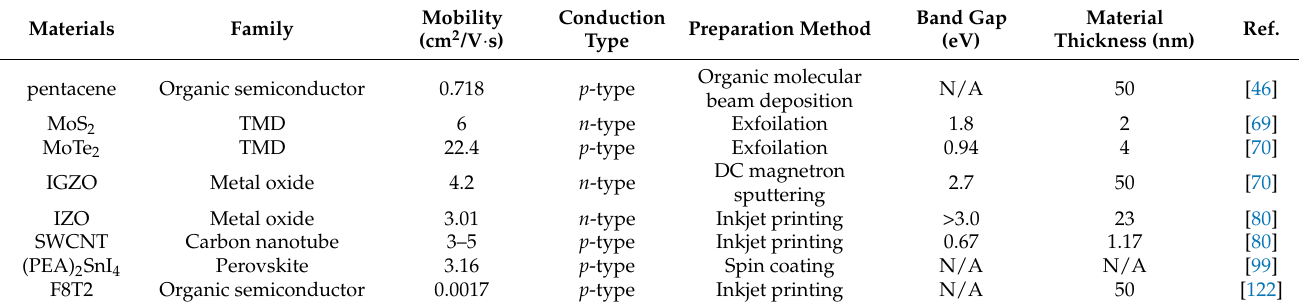
Table 4. Materials properties and preparation process of various semiconductor